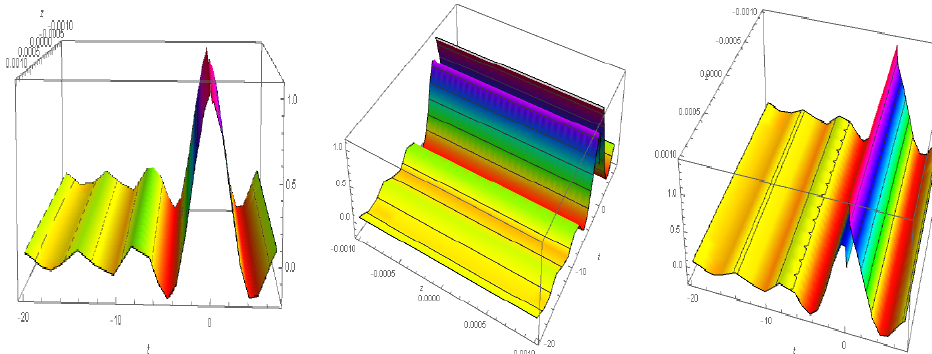
Figure 21. The MS profiles of the solution ∆ 11 in Equation (40) are constructed for values of b 1 = 0.5, p = 1, a 4 = 3, a 2 = 2, k 1 = 0.1, ν = 1 and T r = 2. Three-dimensional graphs at (i) a 5 = − 5, (ii) a 5 = 3 and (iii) a 5 = 10.